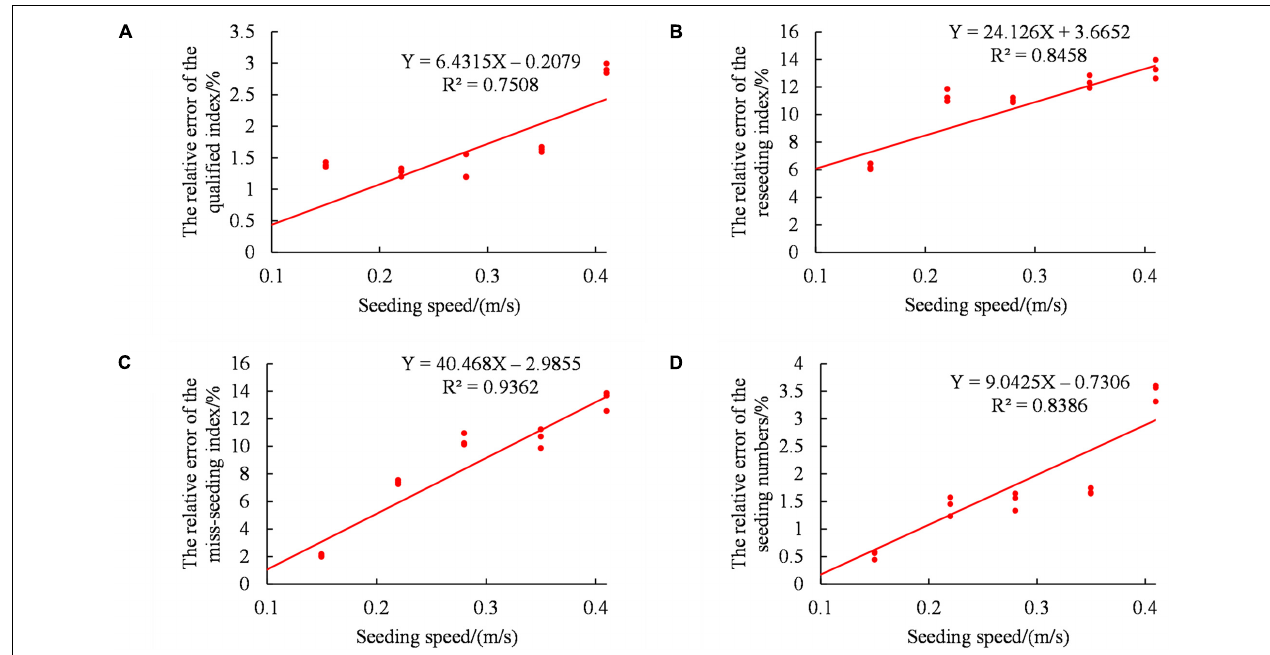
FIGURE 12 | Influence of the seeding speed on the monitoring accuracy of the sensor. (A) Relative error of the qualified index. (B) Relative error of the reseeding index. (C) Relative error of the miss-seeding index. (D) Relative error of the seeding amount.